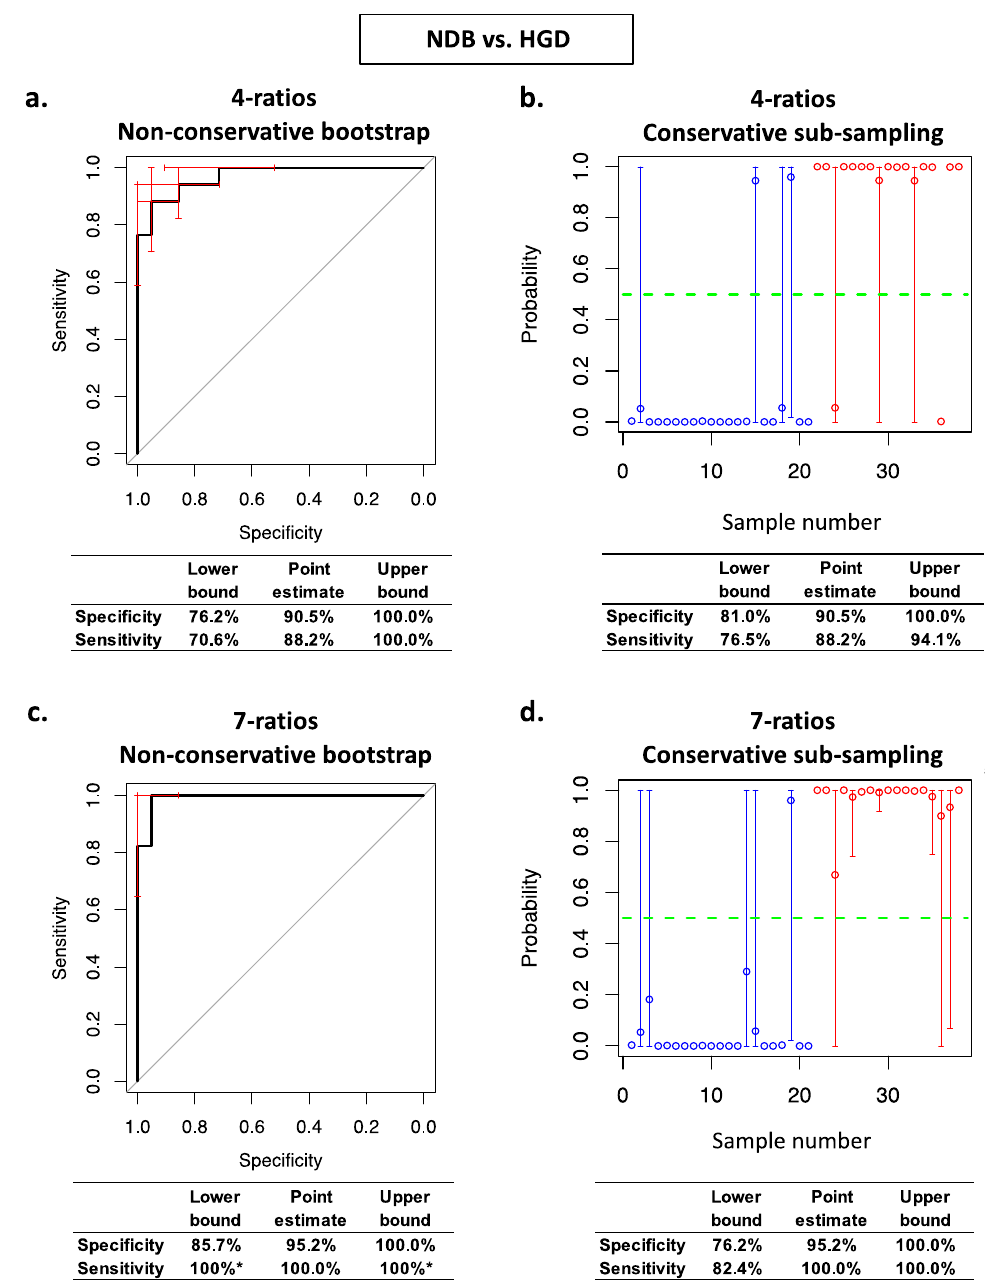
Figure 3. Stabilised nested cross validation ROC curves, prediction probability plots, and associated specificity and sensitivity estimates for NDB vs. HGD. Panels ( a , c ): ROC curve error bars (red) are non-conservative bootstrapped 95% confidence intervals for sensitivity and specificity at each threshold. Panels ( b , d ): circles are average prediction probabilities per sample. Error bars are the conservative prediction probability 95% confidence intervals for each sample. Blue circles are NDB samples and red circles are HGD samples. * confidence intervals cannot be estimated using non-conservative bootstrap resampling when the NDBs and HGDs are perfectly separated.